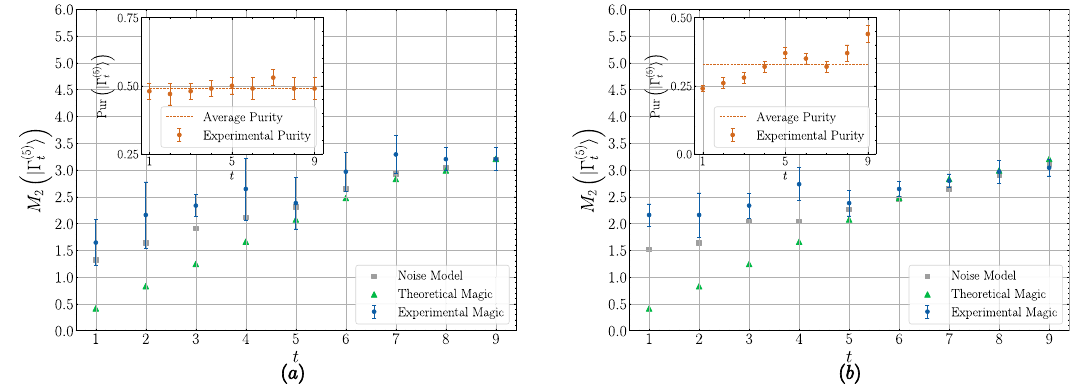
Fig. 6 Stabilizer 2-Rényi for n = 5. Plot of the stabilizer 2-Rényi for a ibmq_quito and b ibmq_casablanca. Both fi gures contain the experimental values (blue dots), the theoretical values (green triangles) of the magic for the pure state one would have liked to obtain, and the noise model values (gray squares) of the magic for the mixed state prepared on the quantum processor. The values of the magic of the (cid:5) E (cid:5) Γ ð 5 Þ (cid:5) -states for t = 1, … , 9 are plotted as functions of the number of T -gates t in the doped random Clifford circuits,(see Supplementary Tables t III and IV in Supplementary Note 4 for the data). See Fig. 3 for the preparation of such states. Both fi gures contain in the upper left corner the purity (orange dots) of the output state prepared on the quantum processor and its average value (dashed line). Here the number of resources N TOT ≡ N U × N M depends on the number of T -gates t thrown in the circuits as N TOT ¼ 2 A 5 þ B 5 ð 9 (cid:2) t Þ , where A 5 = 13.7 ± 0.1, B 5 = 0.041 ± 0.02 , see Supplementary Table I in Supplementary Note and Fig. 7 in “ Methods. ” Note that the experimentally observed magic can be — and typically is — higher than the theoretically predicted magic. See the caption of Fig. 4 for an explanation.